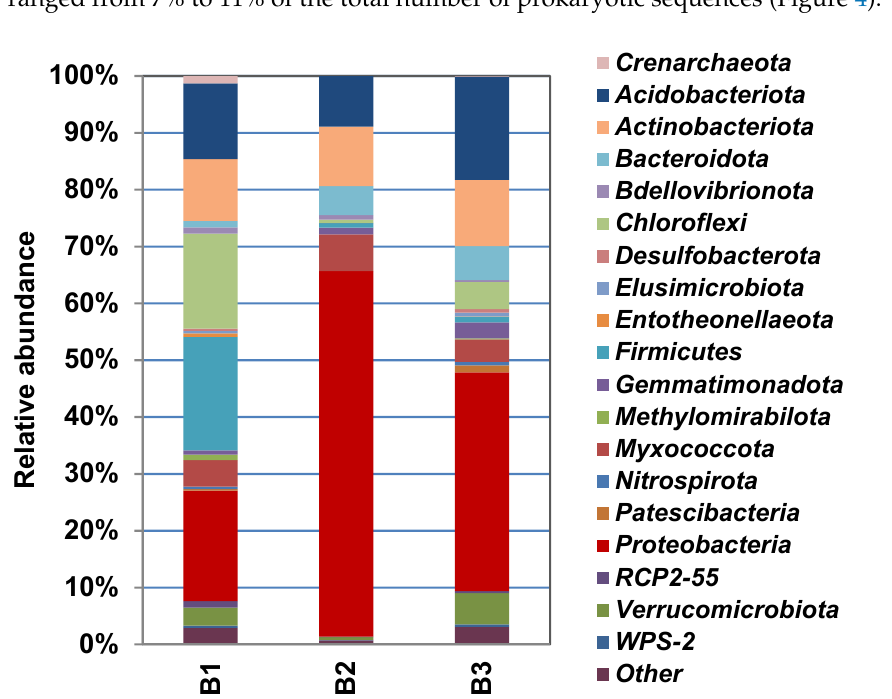
Figure 4. Taxonomic classification of prokaryotic communities (at the phylum level) in libraries of 16S rRNA gene fragments derived from samples of alluvial brown soil (B1), leaf litter (B2) and soil from epiphyte baskets (B3) collected in the territory of the Pu Hoat Nature Reserve.